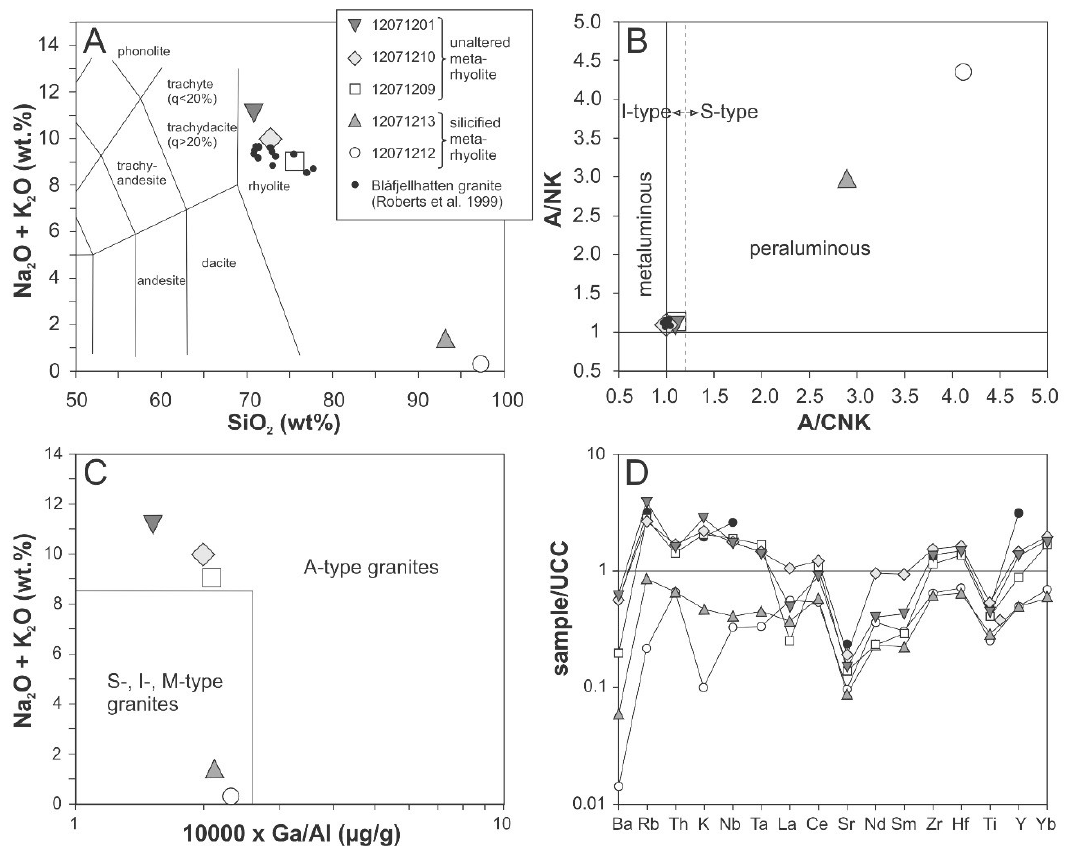
Figure 6. Whole rock chemistry of breccia host rocks. ( A ) Total alkali oxide vs. silica (TAS) classification diagram for volcanic rocks. ( B ) A/CNK versus A/NK (A/NK = molar ratio of Al 2 O 3 /(Na 2 O + K 2 O); A/CNK = molar ratio of Al 2 O 3 /(CaO + Na 2 O + K 2 O) discrimination plot according to Shand [50]. ( C ) discrimination plot of A-type and other granites according to Whalen et al. [47]. ( D ) Upper continental crust (UCC)-normalized diagram of selected incompatible elements. UCC values are from Rudnick and Gao [51].